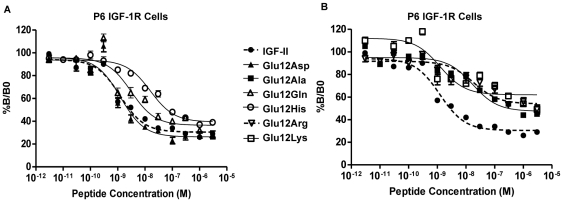
Dose-response curves for negative cooperativity.Accelerated dissociation of prebound Eu-IGF-II in the presence of increasing concentrations of (A) IGF-II (•), Glu12Asp IGF-II (▴),Glu12Gln IGF-II (▵), Glu12His IGF-II (○) and (B) IGF-II (•), Glu12Ala IGF-II (▪), Glu12Arg IGF-II (▿) or Glu12Lys IGF-II (□) from the IGF-IR on P6 IGF-1R cells. Results are expressed as a percentage of binding in the absence of competing ligand (%B/Bo) after 30 min, and the data points are the mean±SEM of three assays with each concentration measured in triplicate. Error bars are shown when greater than the size of the symbols. Curves are separated into two graphs for clarity.